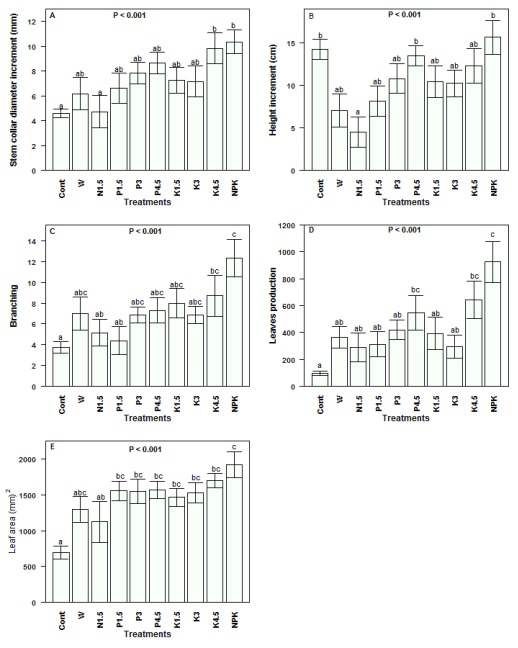
Vegetative growth response of
Synsepalum dulcificum juveniles under various treatments.(
A) Stem collar diameter; (
B) Height; (
C) Branching; (
D) Leaf production and (
E) Leaf area. Values are means ± SE (n = 8 – 10 seedlings). Means with different letters denote significant differences at P < 0.05, ANOVA, Tukey Test. Cont = rain fed, no exogenous nutrients; W = Daily watering, no exogenous nutrients; N1.5 = Daily watering + 1.5 g N [seedling]
-1; N3 = Daily watering +3 g N [seedling]
-1; N4.5 = Daily watering + 4.5 g N [seedling]
-1; P1.5 = Daily watering + 1.5 g P [seedling]
-1; P3 = Daily watering + 3 g P [seedling]
-1; P4.5 = Daily watering + 4.5 g P [seedling]
-1; K1.5 = Daily watering +1.5 g K [seedling]
-1; K3 = Daily watering + 3 g K [seedling]
-1; K4.5 = Daily watering + 4.5 g K [seedling]
-1; NPK = Daily watering + 1.5 g N + 1.5 g P + 1.5 g K [seedling]
-1.